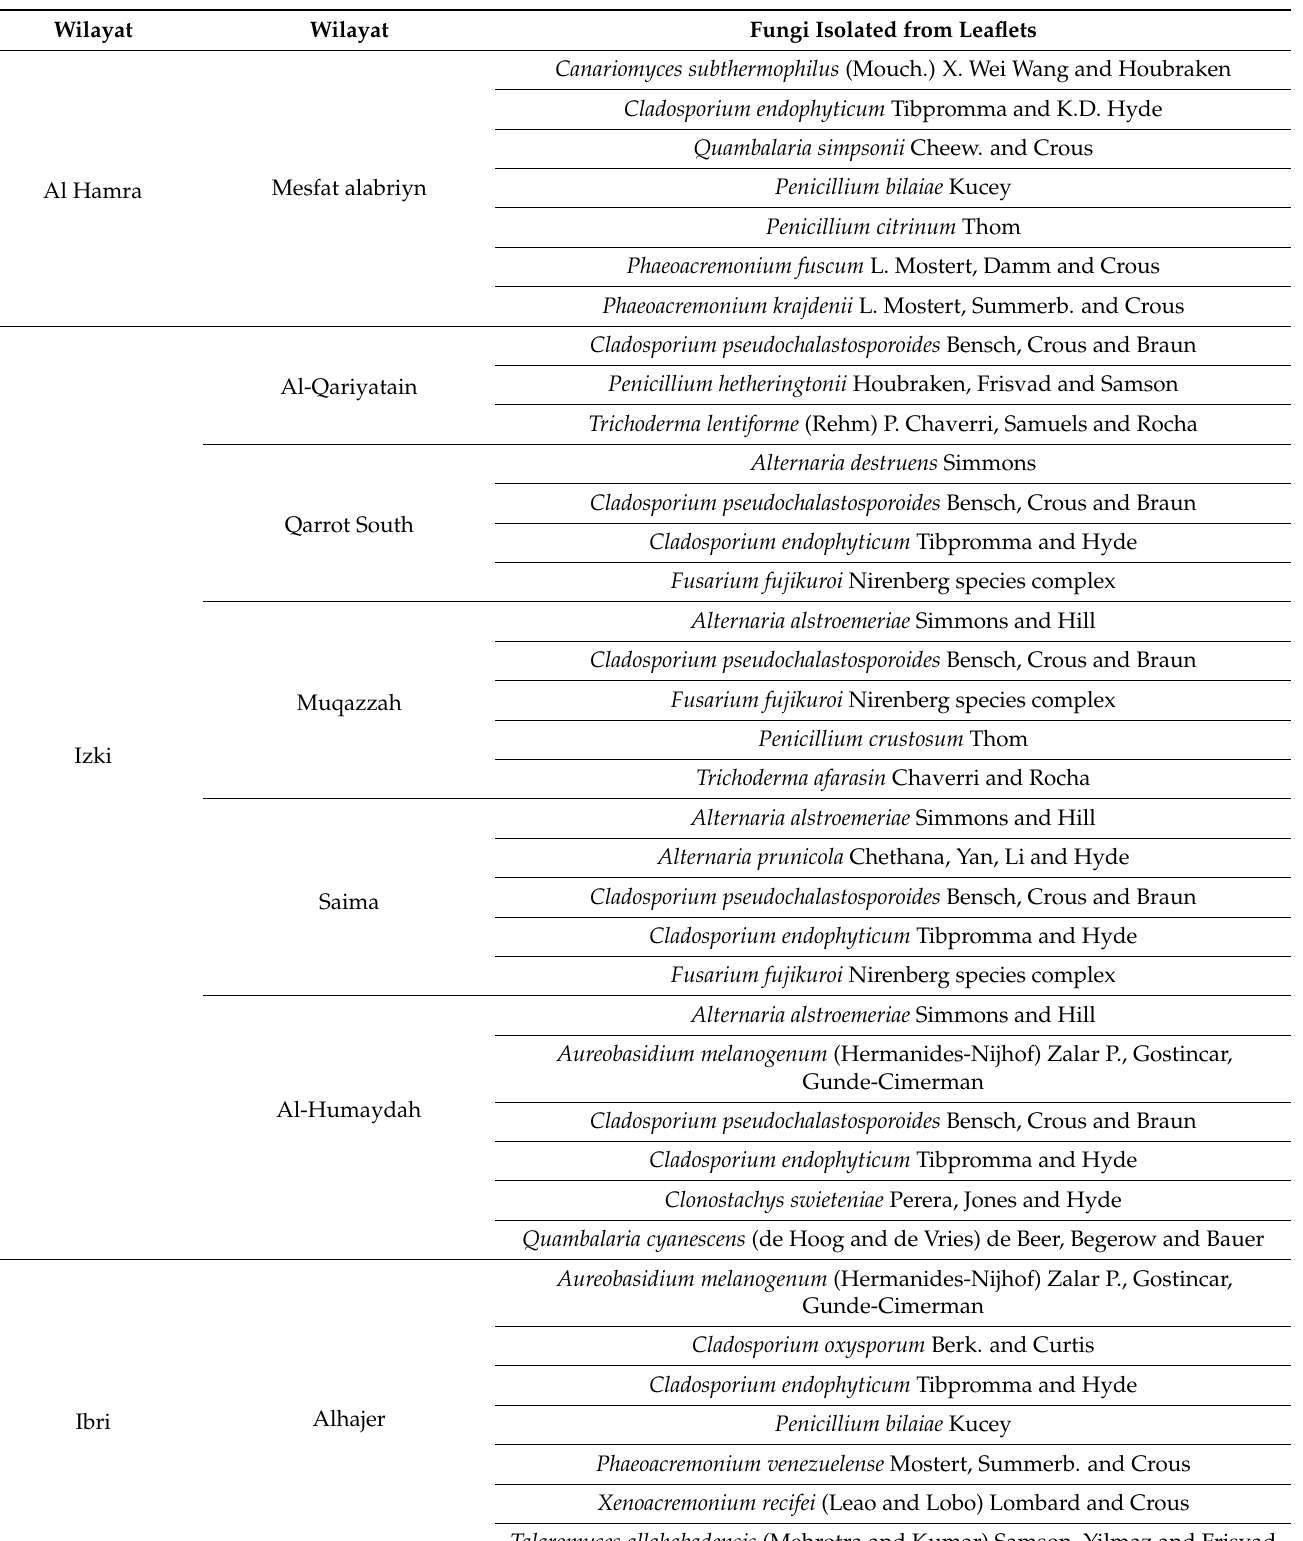
Table 2. Fungal species isolated from the infected leaves of date palm collected from different villages in